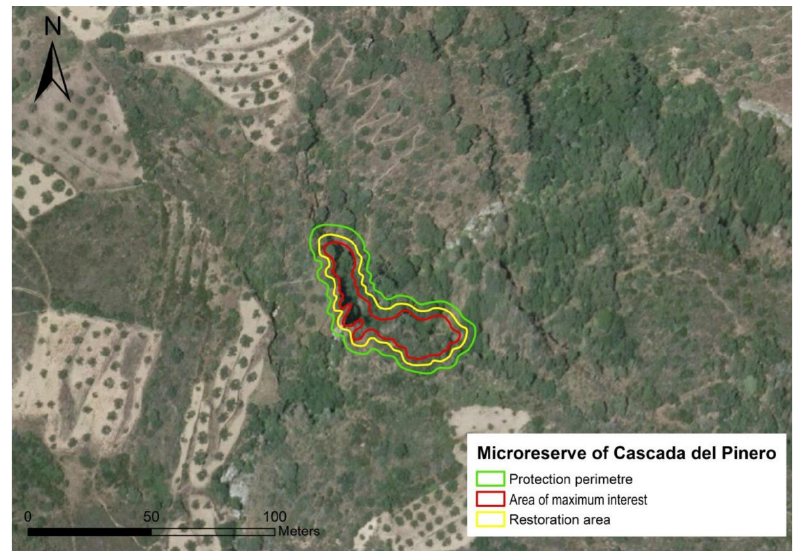
Figure 4. Proposal of Plant Micro-reserve in the enclave of Cascada del